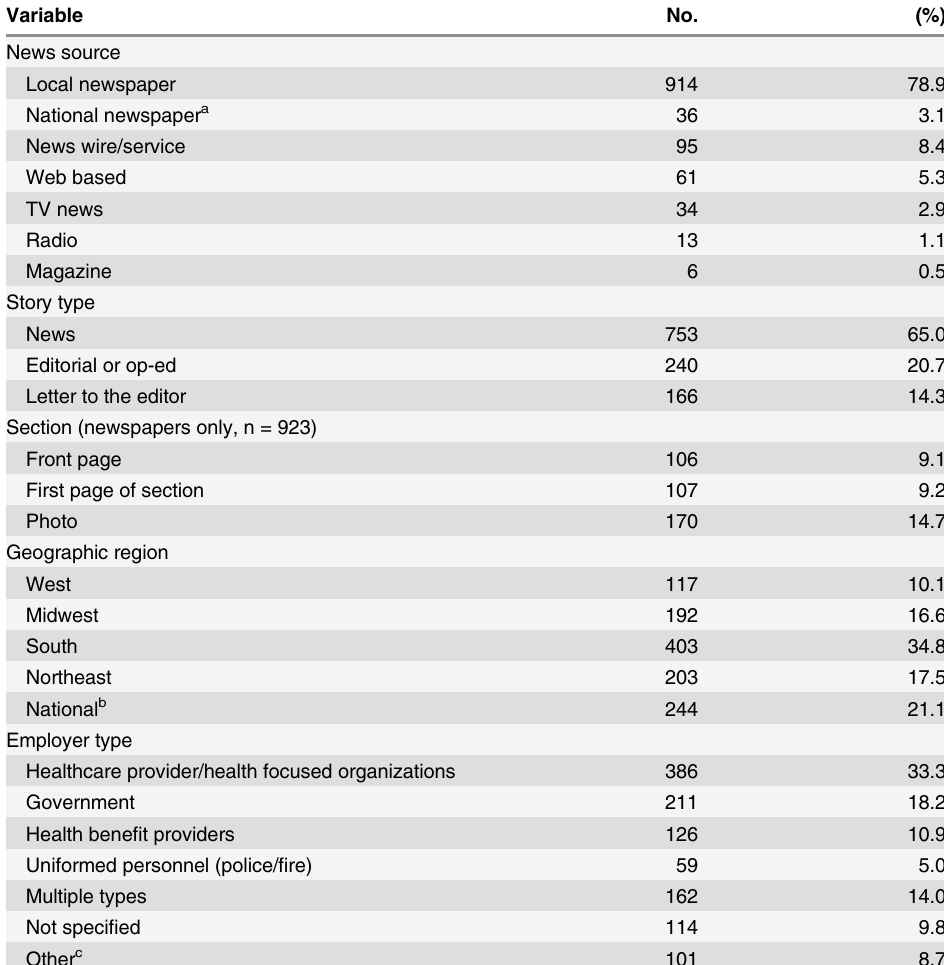
Table 1. News Items (n = 1,159) on employers with policies to hire only nonsmokers: United States, 1995 –